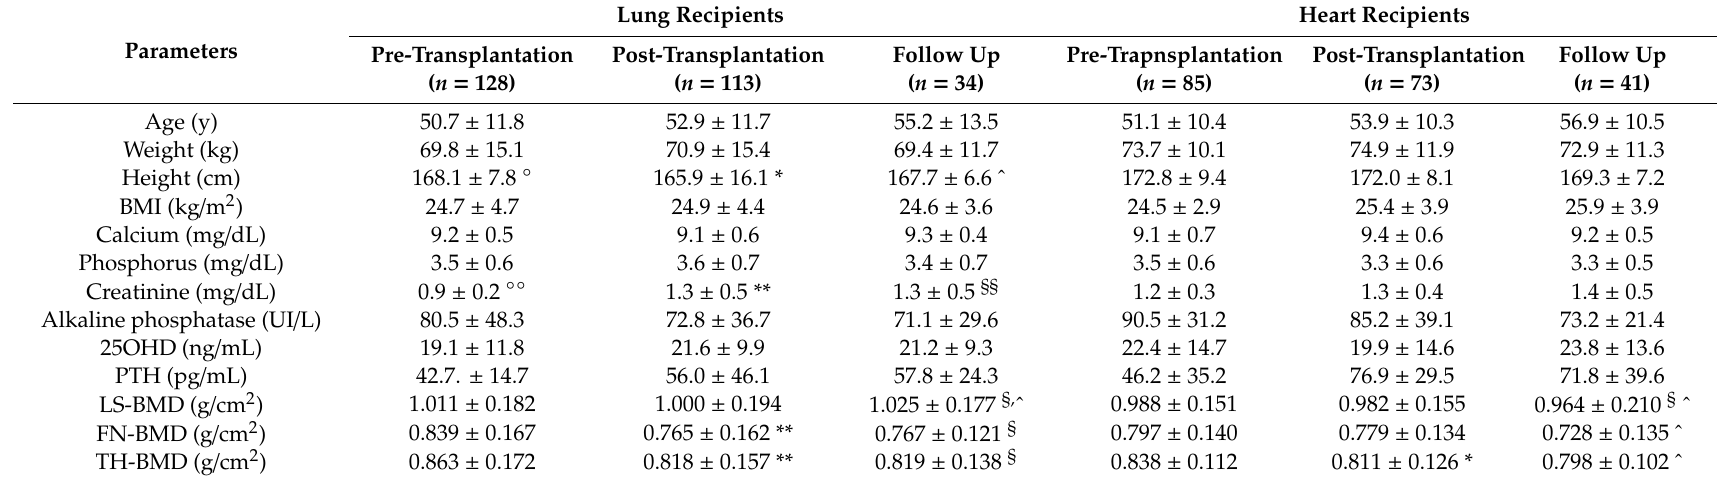
Table 1. Clinical characteristics and biochemical and densitometric parameters at pre-transplantation, post-transplantation, and follow up in lung and heart recipients.